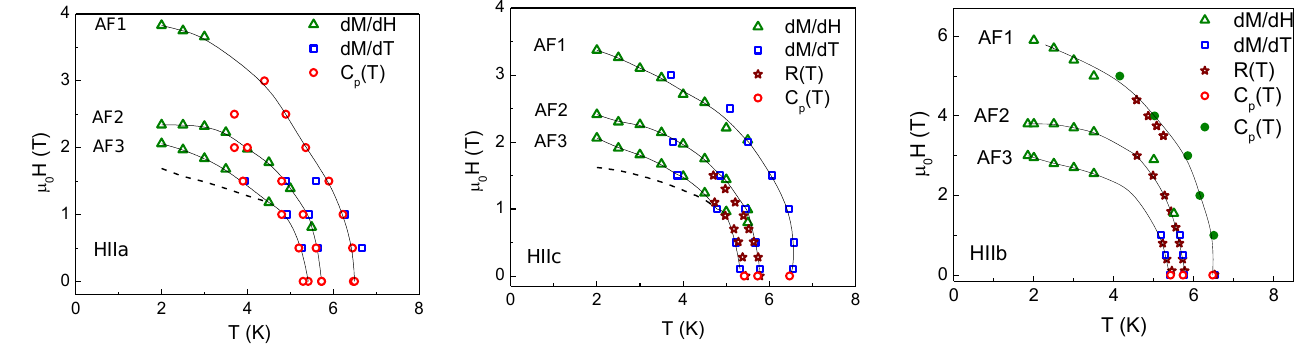
Figure 6. Magnetic phase diagrams of TbTe 3 in a magnetic field oriented along a , b , and c axes. The dash lines mark positions of additional, sometimes smeared anomalies. Solid circles are taken from Ref. [14].